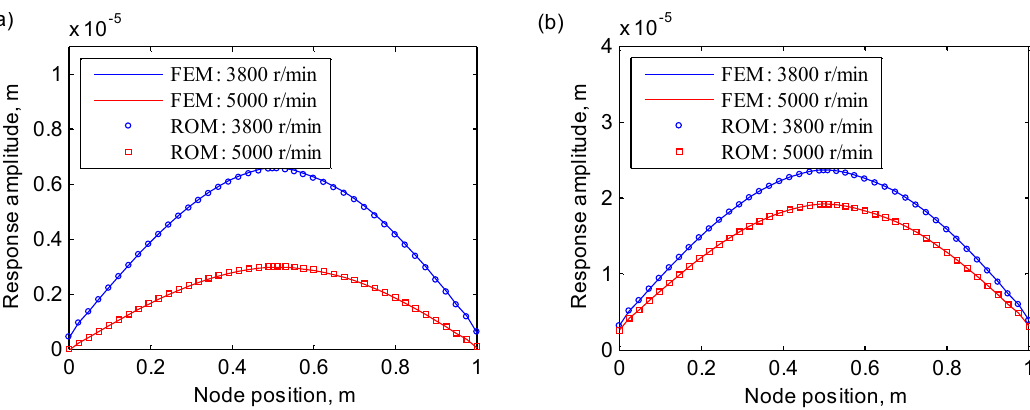
Figure 5. The response amplitudes of nodes on shaft axis of the rotor-bearing system with a 20-mm crack at the speeds of 3800 and 5000 r / min: ( a ) along the horizontal direction; ( b ) along the vertical direction. The labels “FEM” and “ROM” denote the full order model and the reduced order model,